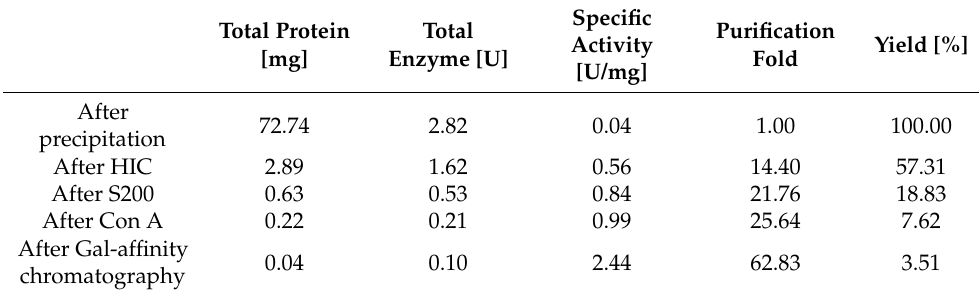
Table 1. Purification protocol of β -galactosidase from A. lusitanicus